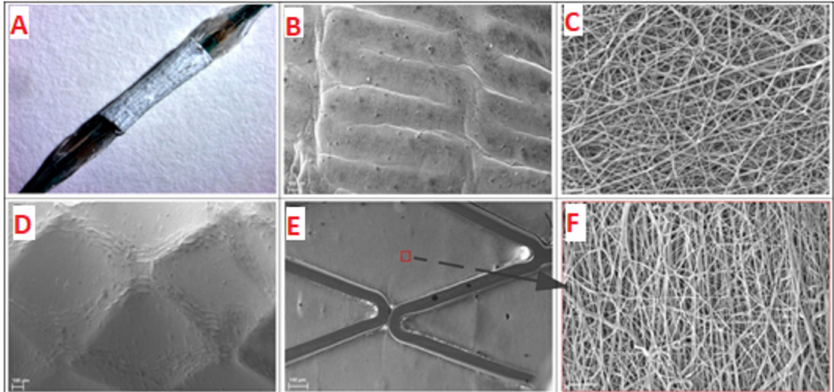
Figure 2. A stent with the electrospun coating installed onto balloon catheter ( A ). Image obtained with SteREO Discovery V12 microscope (Carl Zeiss, Germany). SEM images of coating deformation after installation onto balloon catheter before ( B , C ) and after balloon expansion ( D – F ). Panels B , C , D show outer surface of electrospun coating; panels E and F show inner surface of electrospun coating ( B , D , E panels— × 149 magnification; C , F panels— × 5000 magnification).